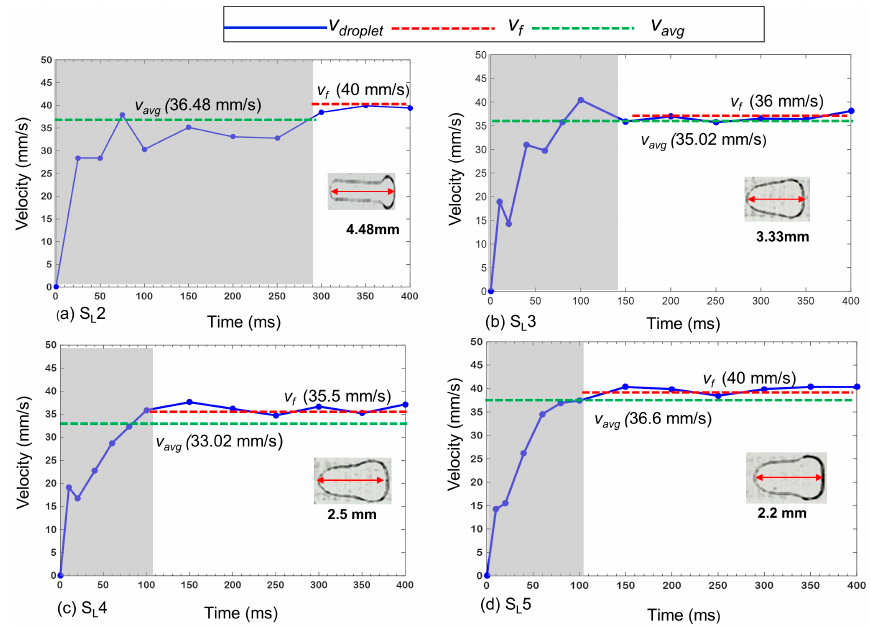
Figure 6. Experimental droplet velocity profiles for slender electrode arrays: ( a ) S L 2, ( b ) S L 3, ( c ) S L 4 and ( d ) S L 5. The insets show droplet shapes in the constant shape region. The shaded regions on the plots depict the transition regions. The red arrows in the insets represent elongated lengths of droplets in the direction of motion. Note that the footprint of the initial shape of the droplet of each case was 2 mm × 2 mm.